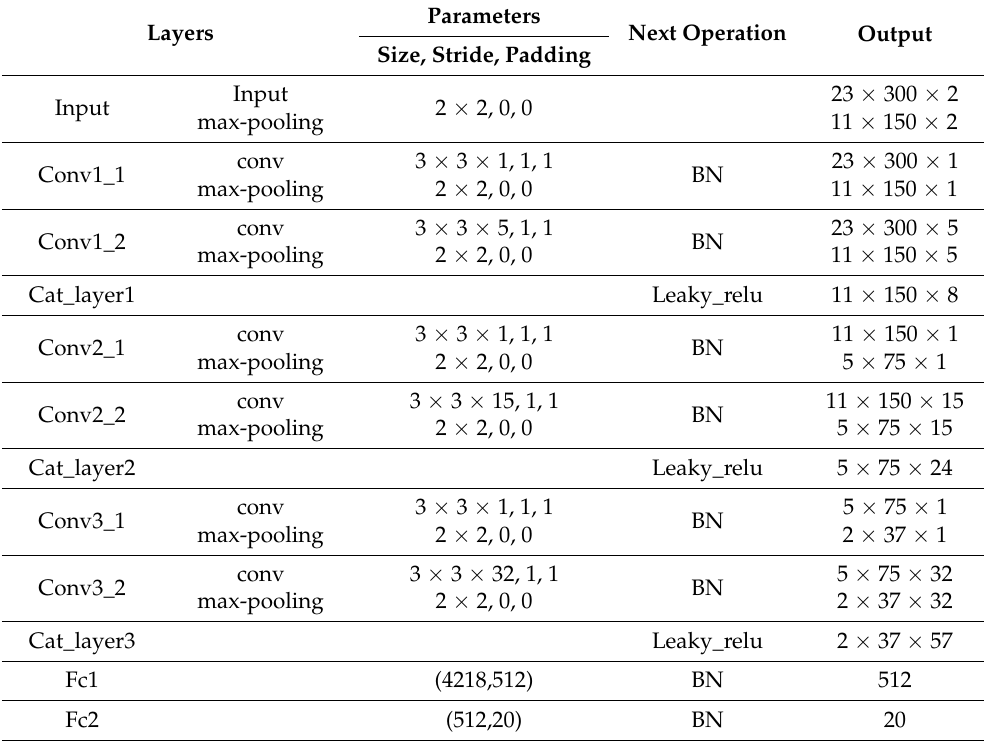
Table 1. Parameters of each layer of the multi-scale convolutional neural network. Parameters Next Layers